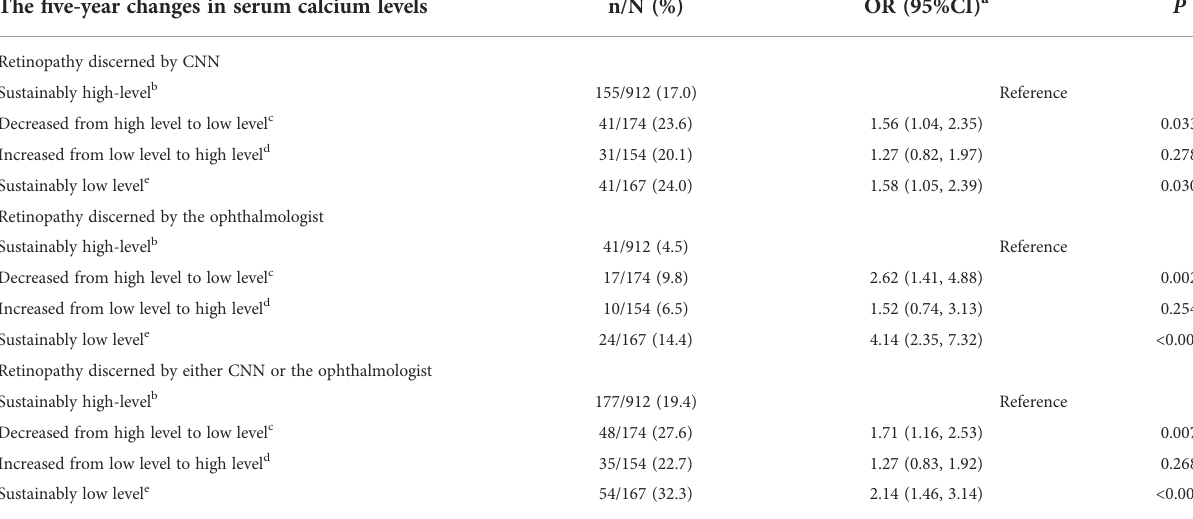
TABLE 3 The association between fi ve-year changes in serum calcium and retinopathy. The fi ve-year changes in serum calcium